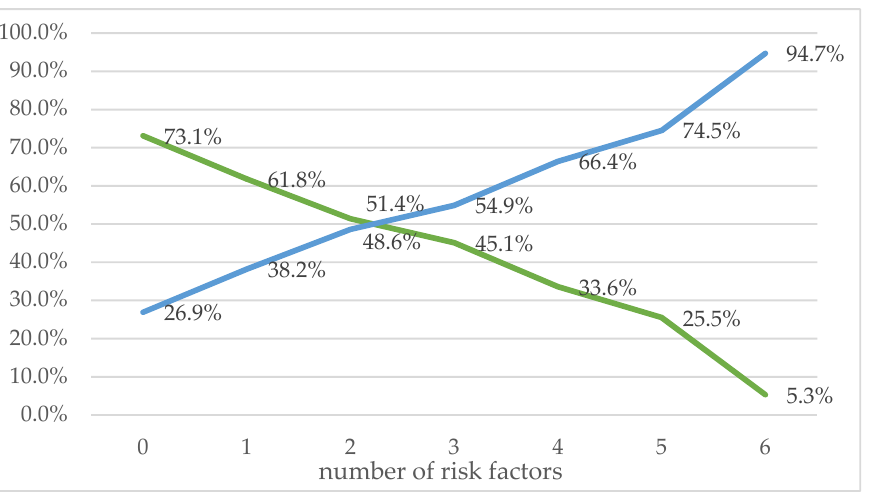
Figure 1. Relationship between the correctness of hand disinfection and the number of risk factors. Blue line—improper hand disinfection; green line—proper hand disinfection.